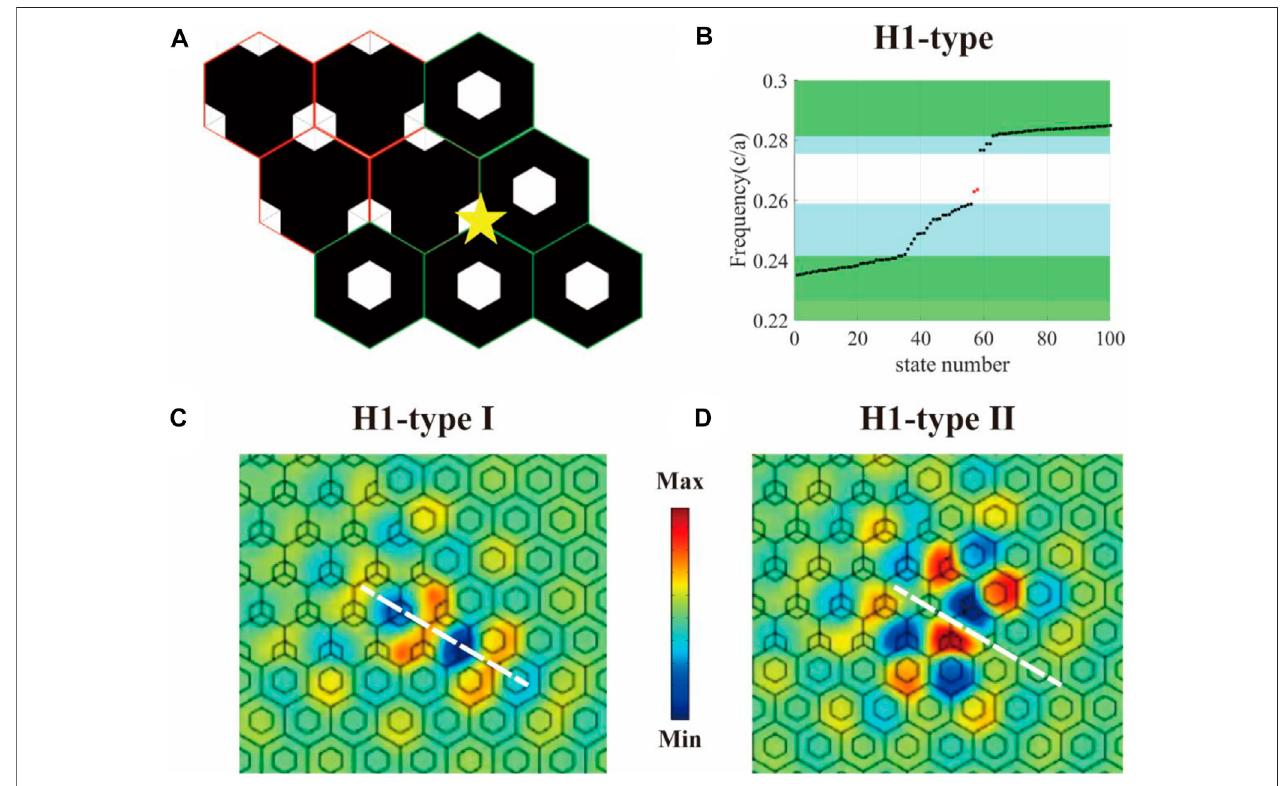
FIGURE 3 | Two types of second-order corner states (SOCSs) in H1-type topological interfaces. (A) Schematic view and (B) eigenmode spectrum of the H1-type topological interface with a 120-deg-bending geometry. The interface is constructed by PC1 and PC3. Green and blue regions indicate the frequency range of bulk states and edge states, respectively. There are two eigenmodes (marked by red point) falling in the band gap and isolating from bulk and edge states, i.e. two types of SOCSs. (C) and (D) Distributionsofreal-part H z fi eldsforthetwoSOCSs.TheSOCSwithevensymmetry(around0.262 c/a )isthetypeIcornerstate(labeledasH1- type-I), while the SOCS with odd symmetry (around 0.263 c/a ) is the type II corner state (labeled as H1-type-II). We use dashed white lines marking the mirror